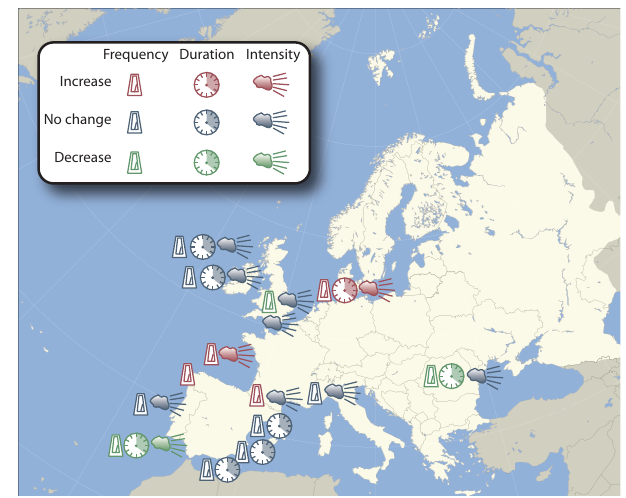
Fig. 1. Trends in European storminess after data discussed in Ciavola et al.